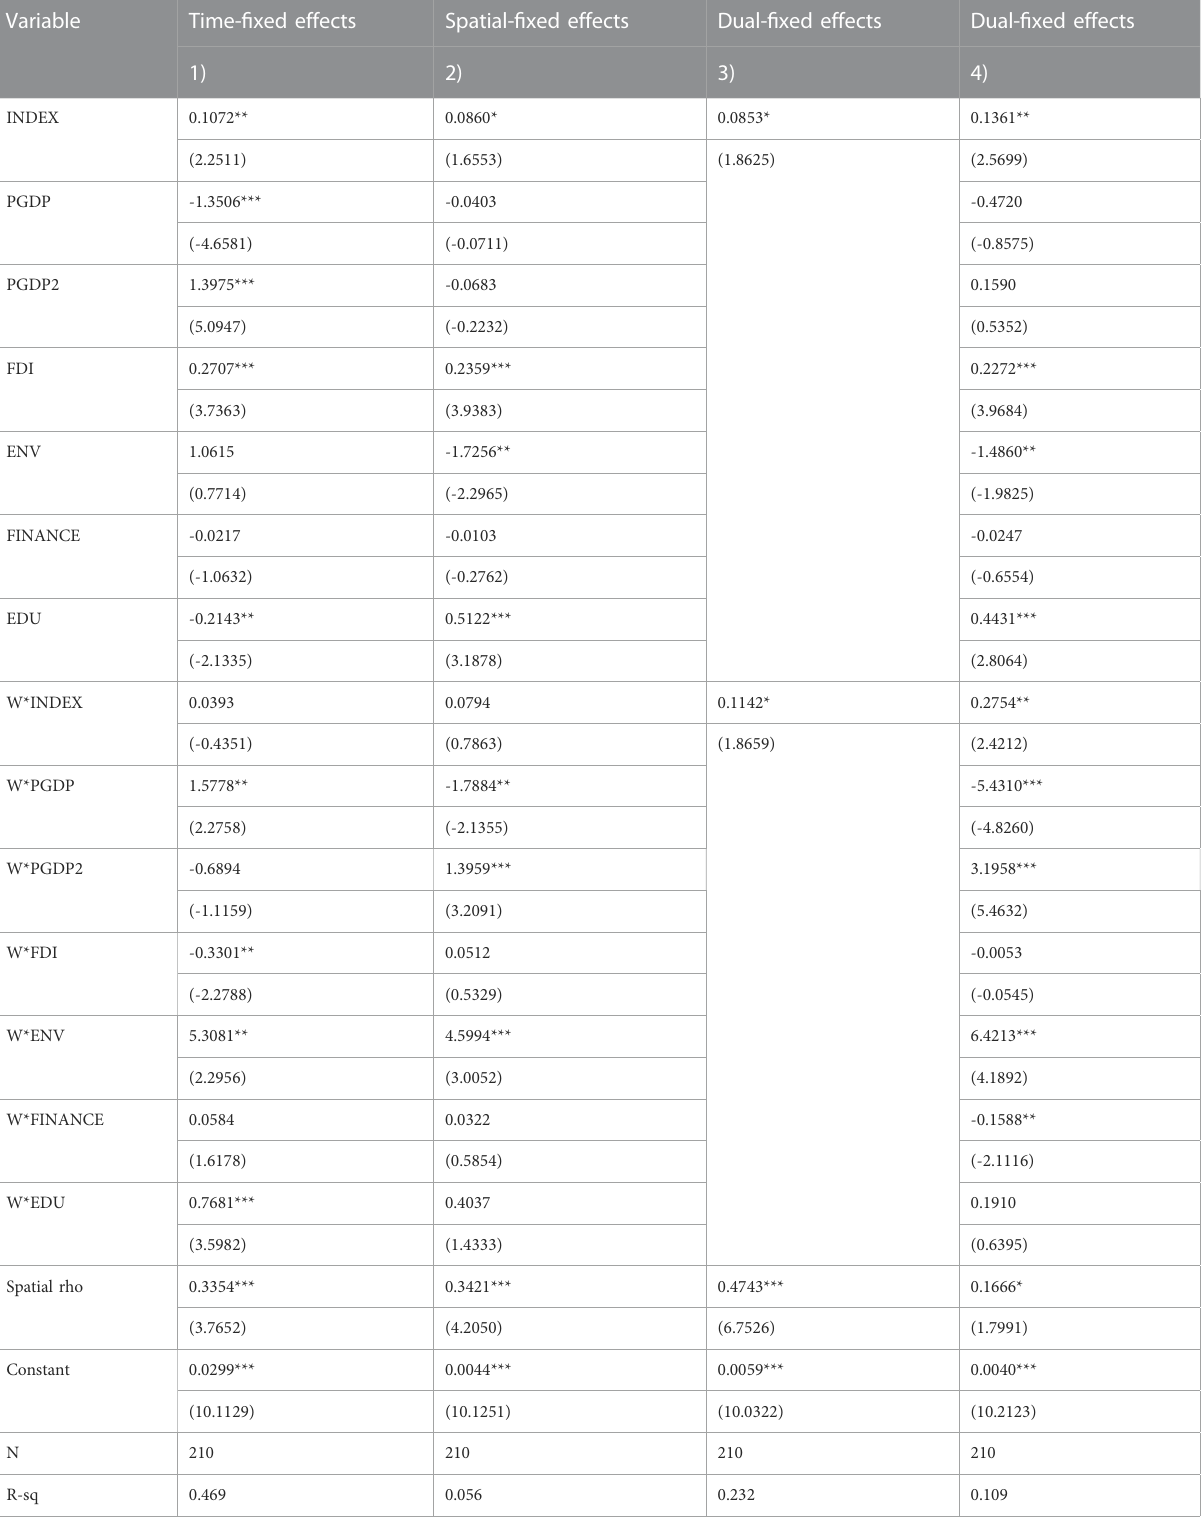
TABLE 4 SDM regression